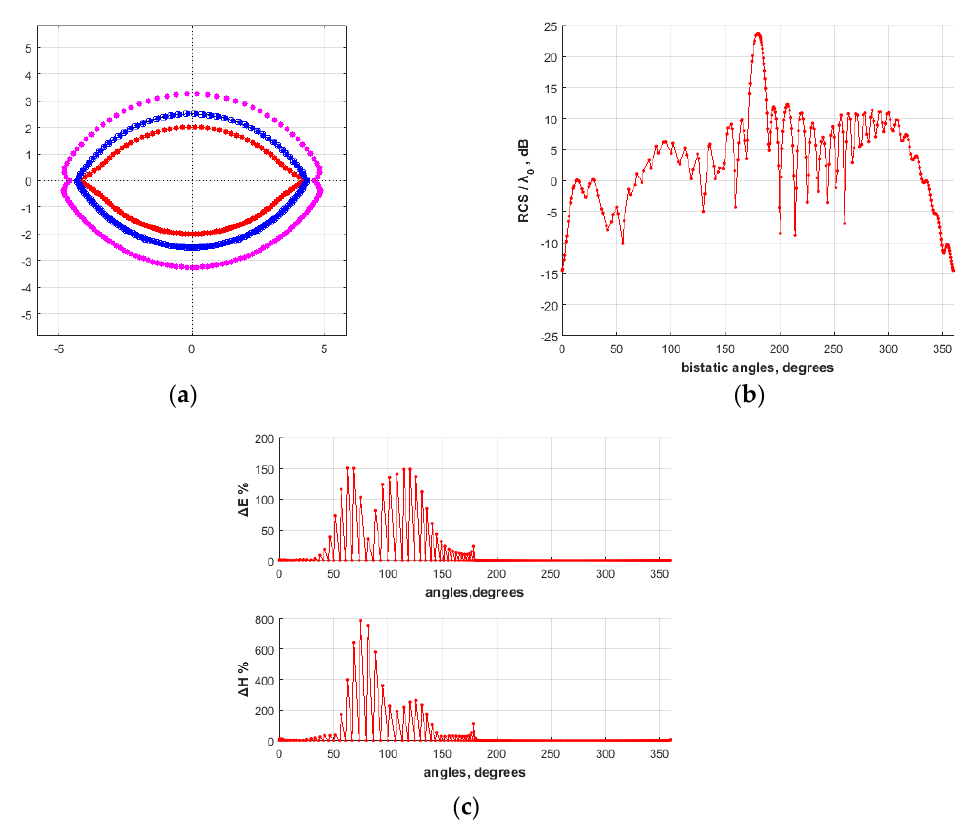
Figure 9. ( a ) Symmetric geometry with non-symmetric auxiliary points allocation, ( b ) RCS, and ( c ) Δ E and Δ H error.